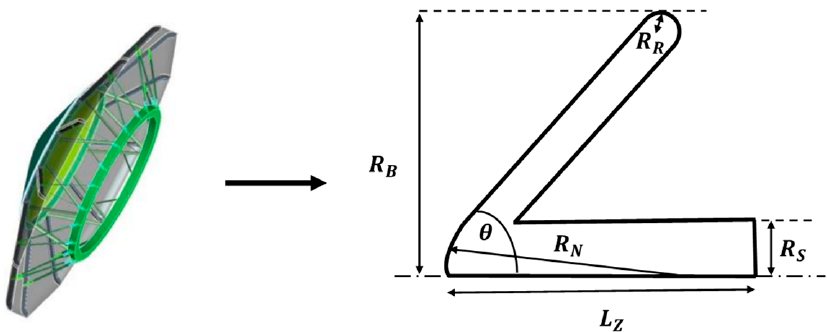
Figure 3. Geometric modeling of reentry vehicle. Table 1. Initial design parameters of reentry vehicle.